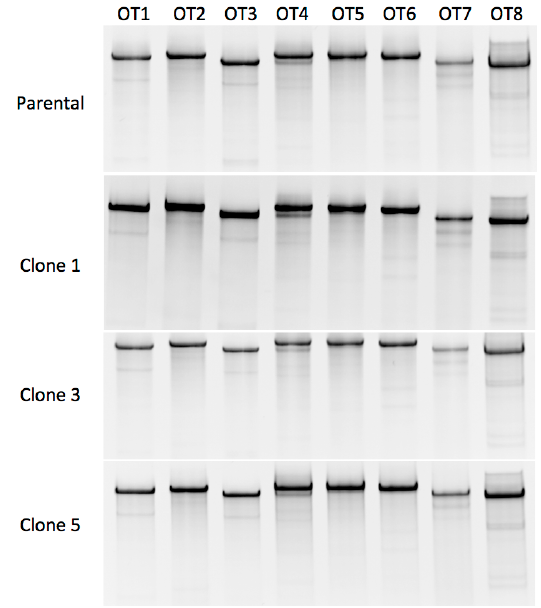
Figure 5. FANCD1 CRISPR/Cas9 reagent off target analysis. At top is the Surveyor analysis for the primary parental fibroblasts. Three gene corrected clones (1, 3, and 5) were also assessed. OT 1–8 corresponds to the genes listed in Table 1.